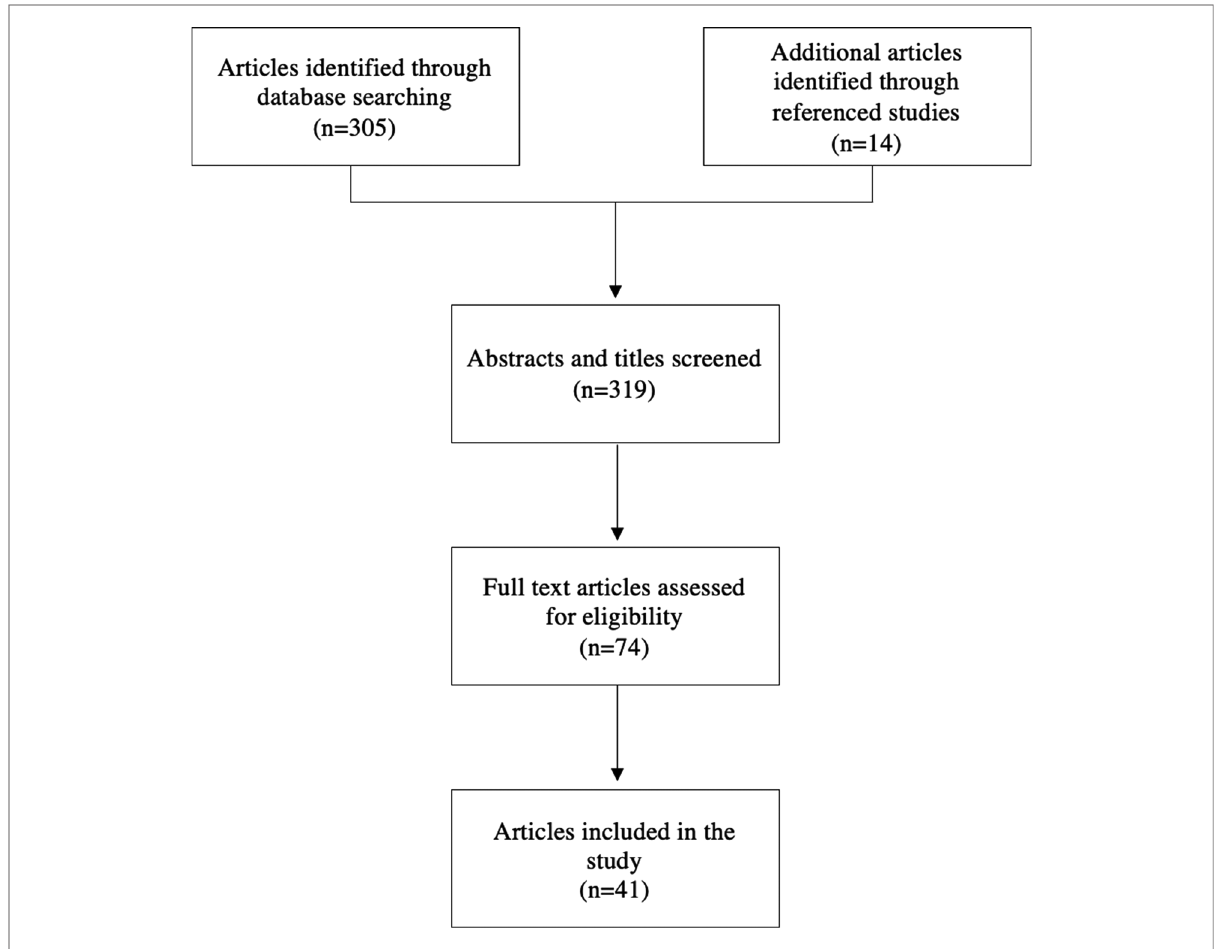
FIGURE 1 Methodology for the selection and exclusion of studies for analysis.